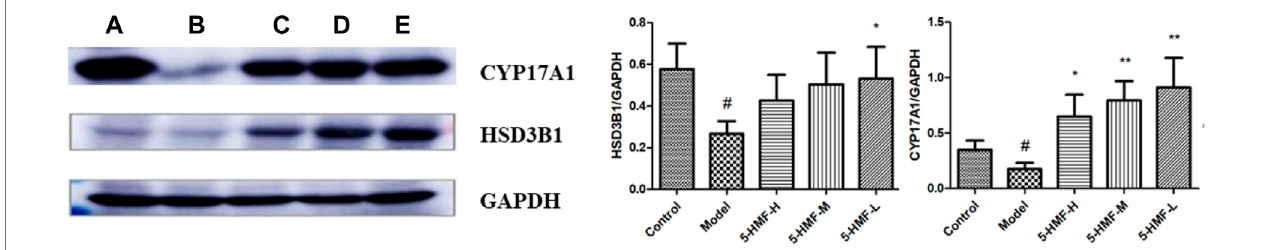
FIGURE 11 | Effect of each group on protein expression. (A) Control group, (B) Model group, (C) 5-HMF-H group, (D) 5-HMF-M group, (E) 5-HMF-L group. # p < 0.05, compared with the control group; *p < 0.05 and **p < 0.01, compared with the model